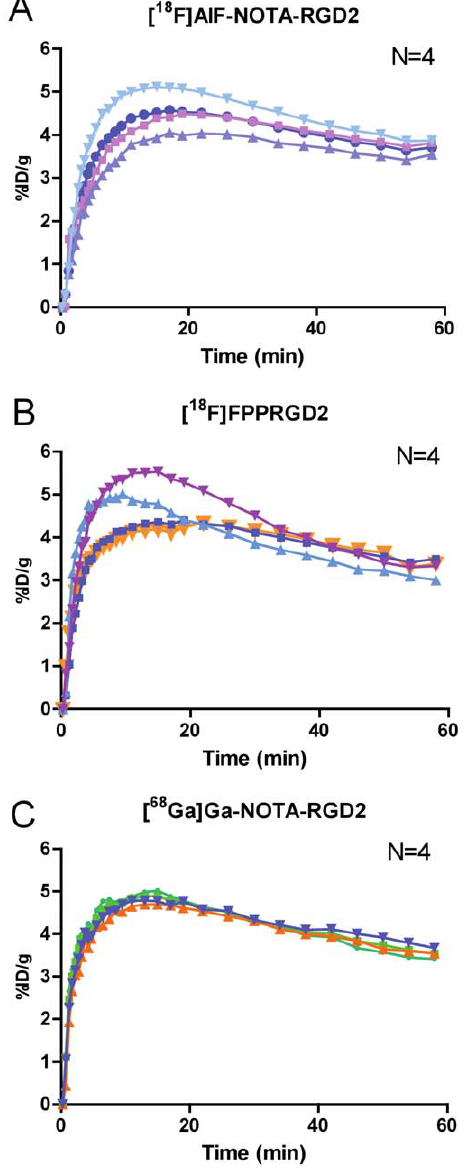
Figure 3. Tumor time-activity curves derived from 60-min dynamic PET scans of mice after administration of dimeric RGD peptide tracers. ( a ) [ 18 F]AlF-NOTA-PRGD2, ( b ) [ 18 F]FPPRGD2, and ( c ) [ 68 Ga]Ga-NOTA-PRGD2 (n=4/group). doi:10.1371/journal.pone.0037506.g003 Figure 4. Representative time-activity curves of major organs